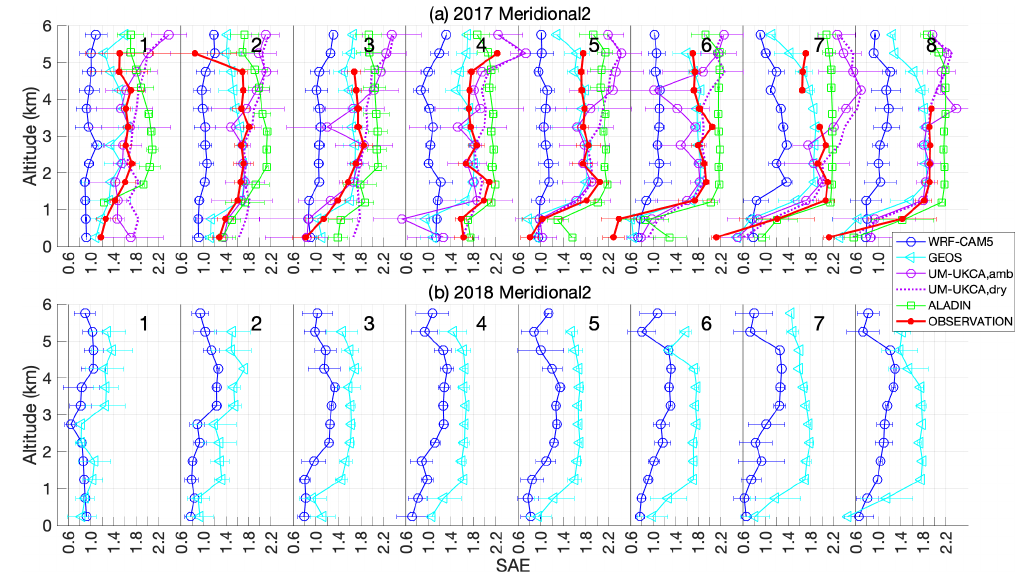
Figure 20. As in Fig. 17 but for the scattering Ångström exponent